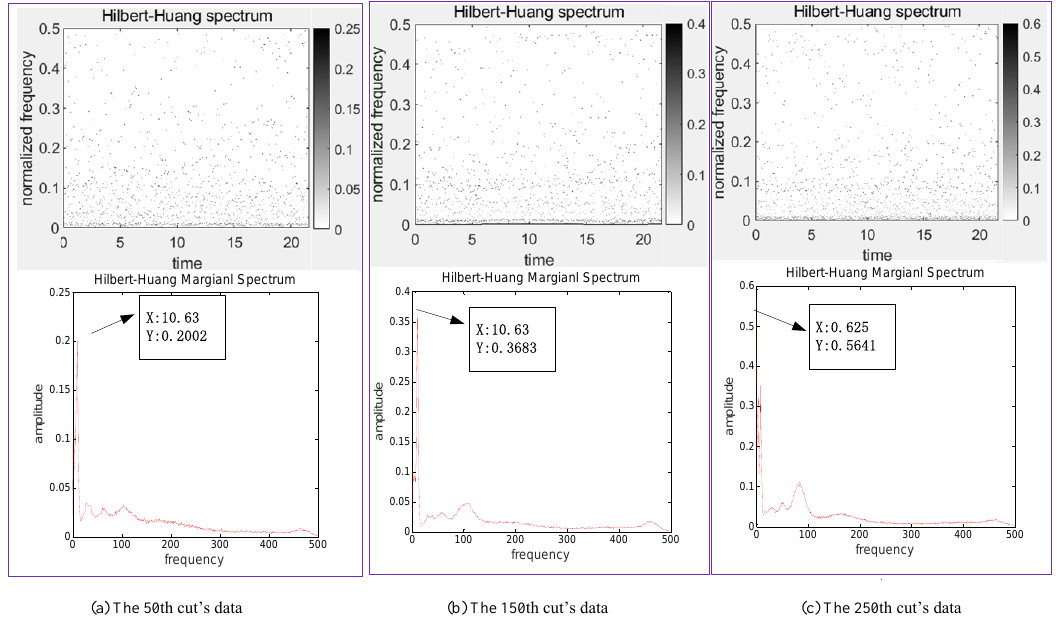
Figure 10. Hibert-Huang spectrum diagrams for the Z-direction of vibration sensor in C1.